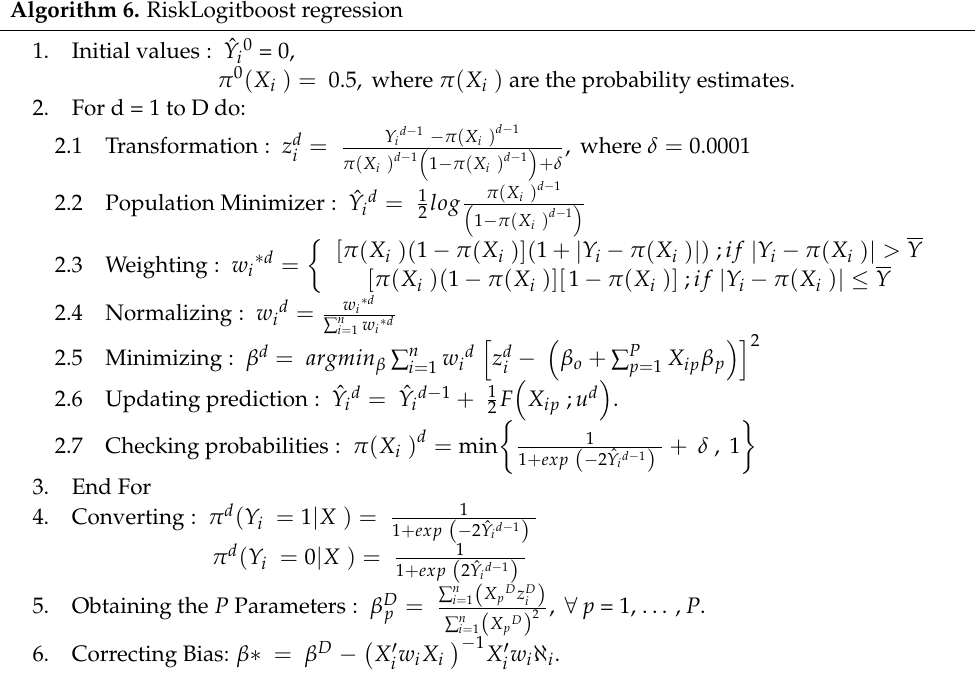
Algorithm 6. RiskLogitboost